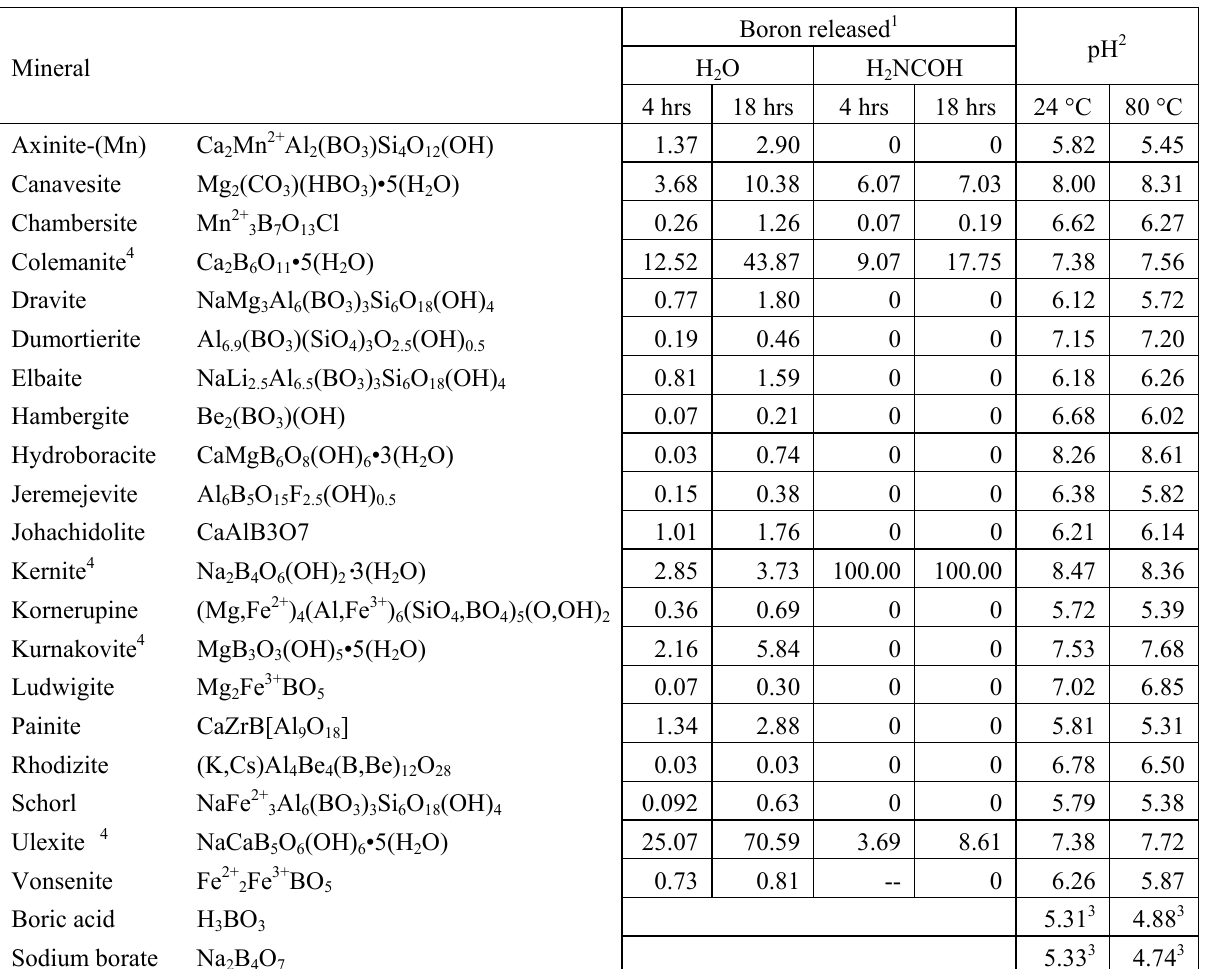
Table 2. Boron release and pH modification by